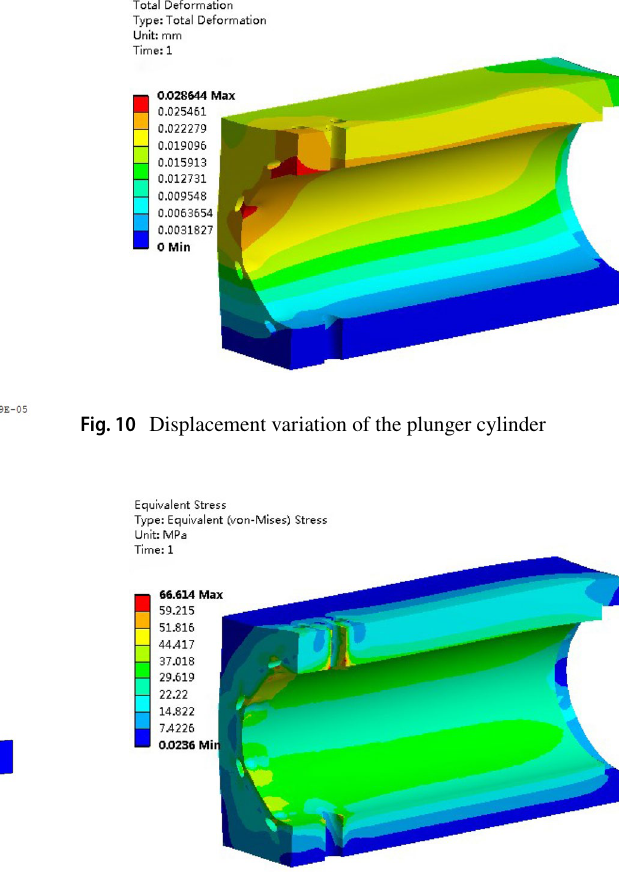
Fig. 11 Equivalent stress of the plunger